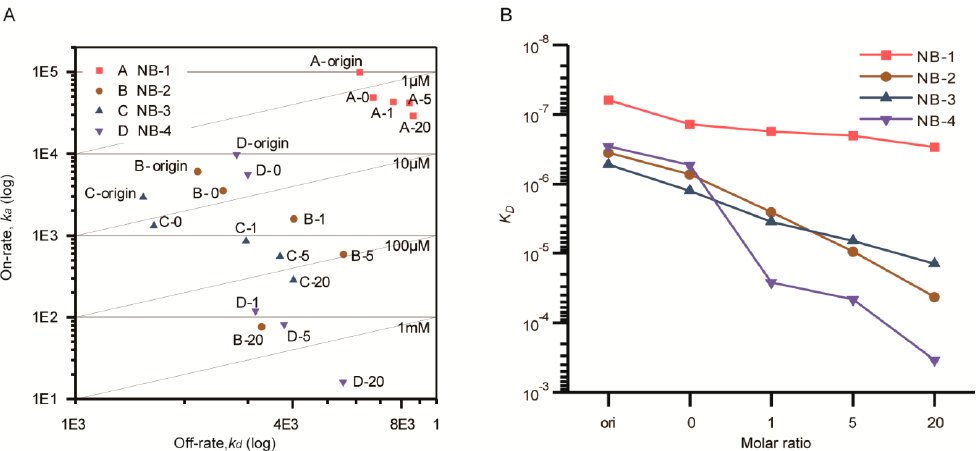
Figure 4. On-Off rate map ( A ) and affinity variation ( B ) of the modified VHH measured by Biacore T200. ( A ) Double logarithm coordinate was used; the diagonal line was equal affinity line ( K D ). ( B ) Single logarithm coordinate was used to show the affinity variation directly. Different VHHs were distinguished by colors. Five samples were measured for each VHH. The point “origin” represented VHHs without any treatment, the point “0” was rated as negative control, the points “1, 5, 20” represented VHHs modified with given molar ratio of NHS-Fluo. The k a of NB-4 modified by a 20 fold amount of NHS-Fluo was outside the limits that can be accurately measured by the Biacore T200 system.